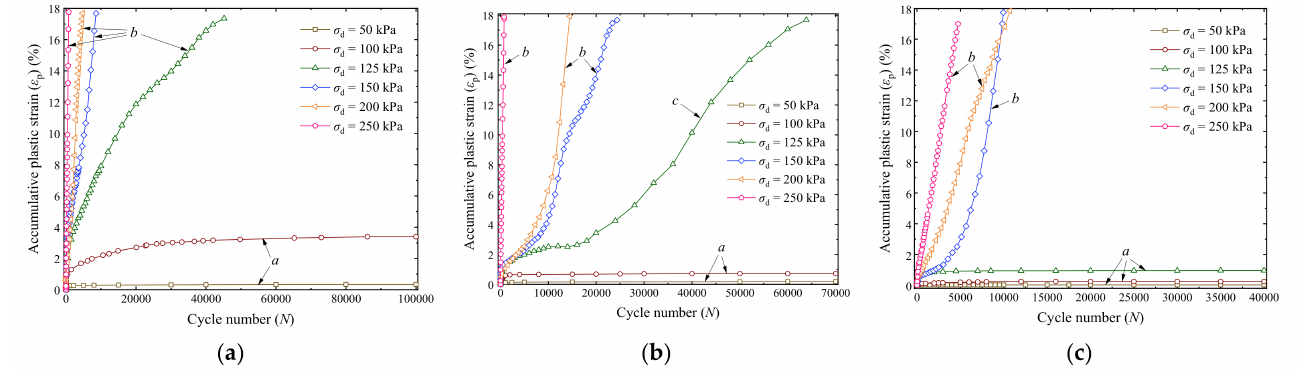
Figure 5. ε p — N relationship of saturation specimens: ( a ) σ 3 = 15 kPa; ( b ) σ 3 = 30 kPa; ( c ) σ 3 = 60 kPa [16].